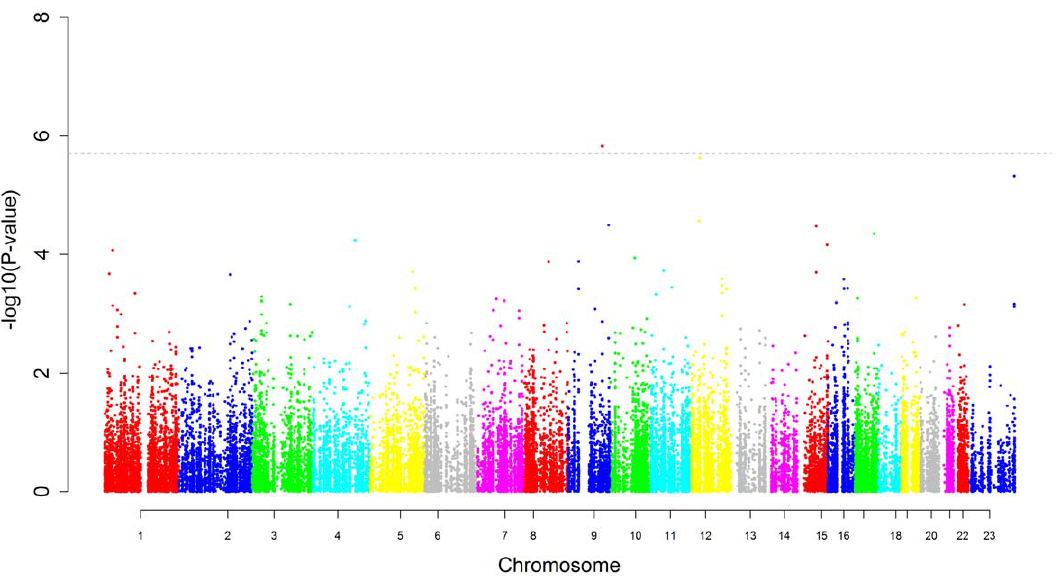
Figure 1. Manhattan plot for apnea hypopnea index in African-Americans. This figure plots the association results for all SNPs against log(apnea hypopnea index + 1) among African-Americans. The y-axis displays the -log(p-value), the x-axis the SNP position on each chromosome. The dotted line represents the threshold for statistical significance based on the number of independent comparisons being made. doi:10.1371/journal.pone.0048836.g001 PLOS ONE |